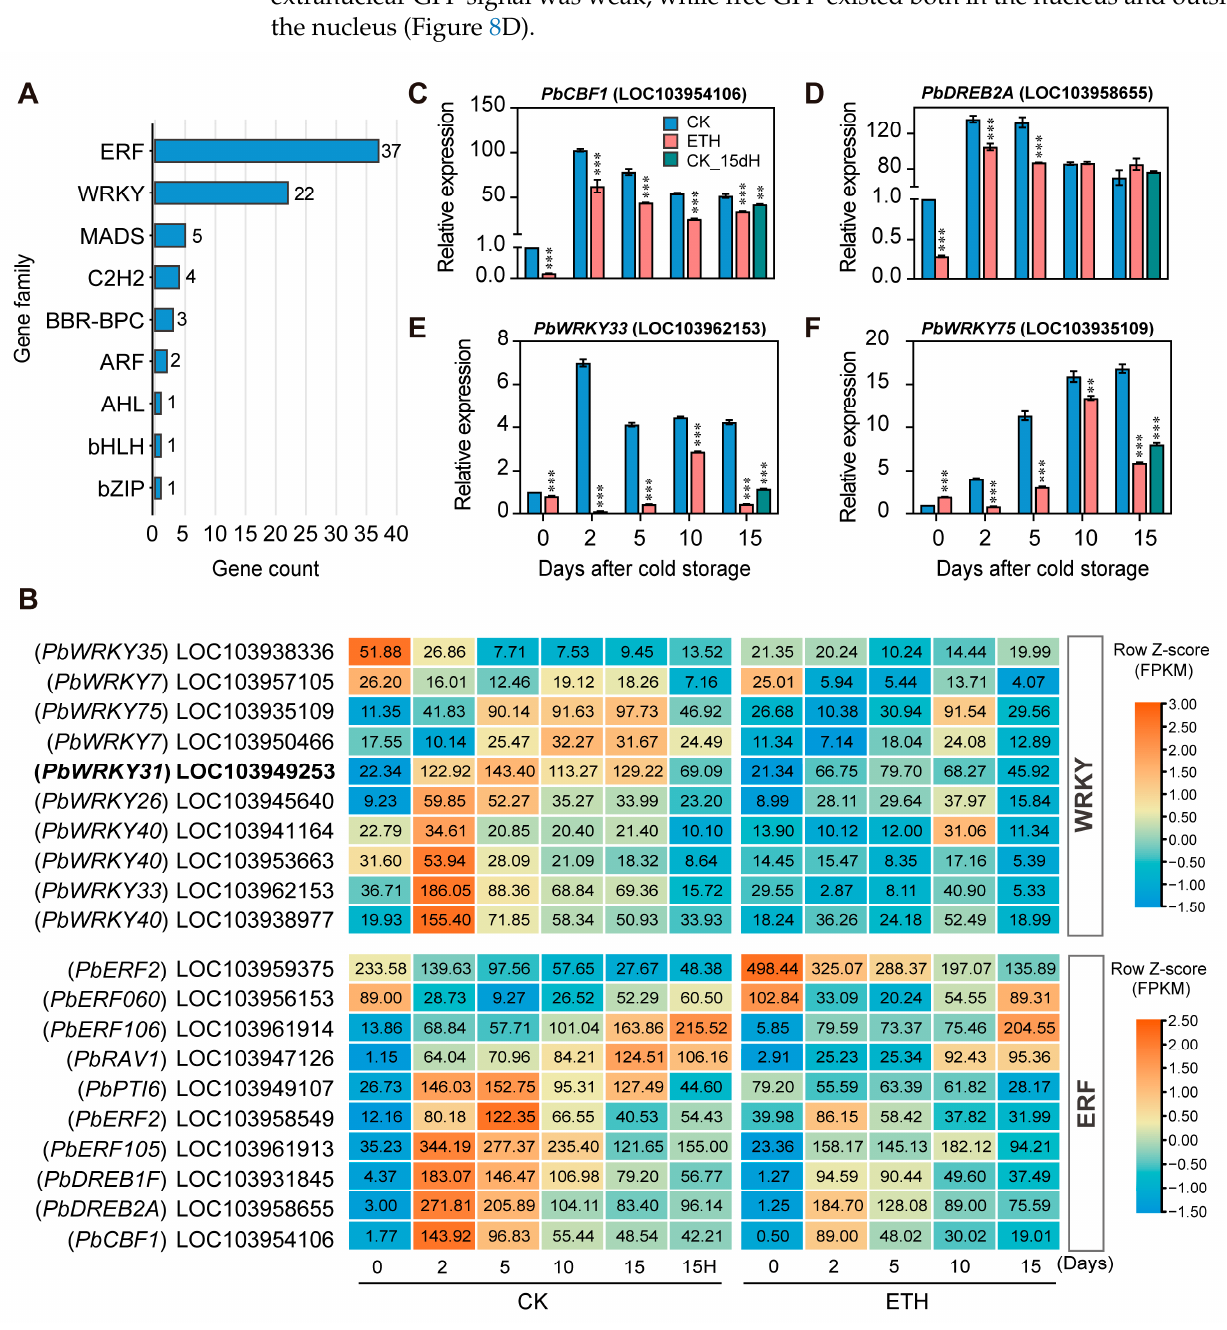
Figure 7. Identification of transcription factors regulating gene expression of the ‘Yellow’ module via CentriMo analysis. ( A ) Counts of different family transcription factors identified via CentriMo analysis. ( B ) Heatmap showing the top 10 expressed transcription factors of the WRKY and ERF families. ( C – F ) Validation of gene expression via a RT-qPCR. All data are mean ± standard deviation from three biological replicates. Asterisks indicate significant differences (** p < 0.01, *** p < 0.001) as calculated using two-tailed Student’s t -test within each time point.